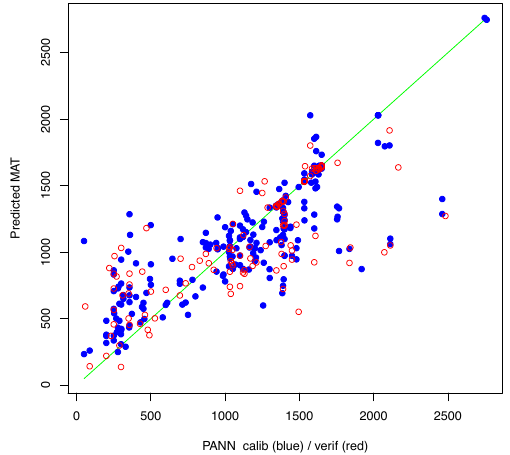
Fig. 8. Validation of the P ann reconstructions performed on the modern pollen data set from West and central Africa.